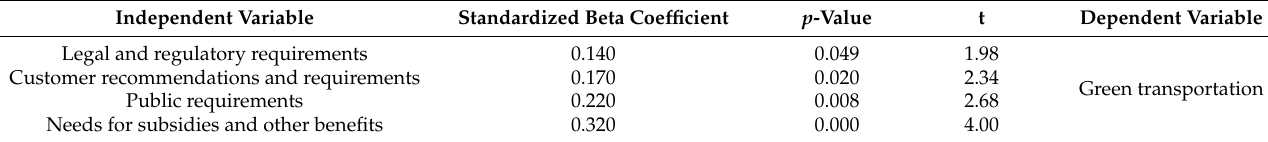
Table 4. Factors influencing the application of green transport.